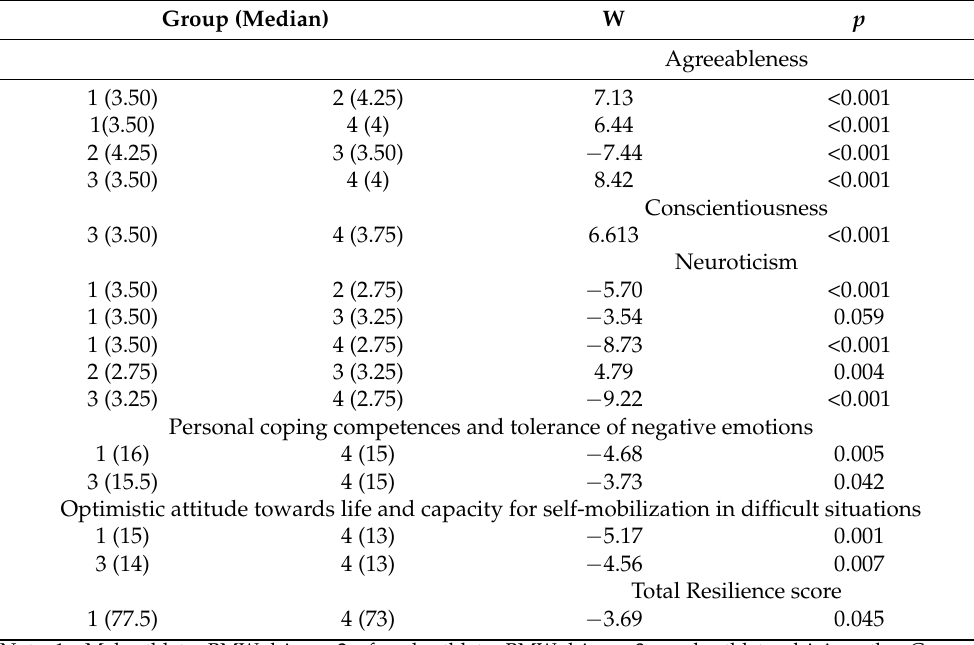
Table 2. DSCF test results for pairwise comparisons with significant